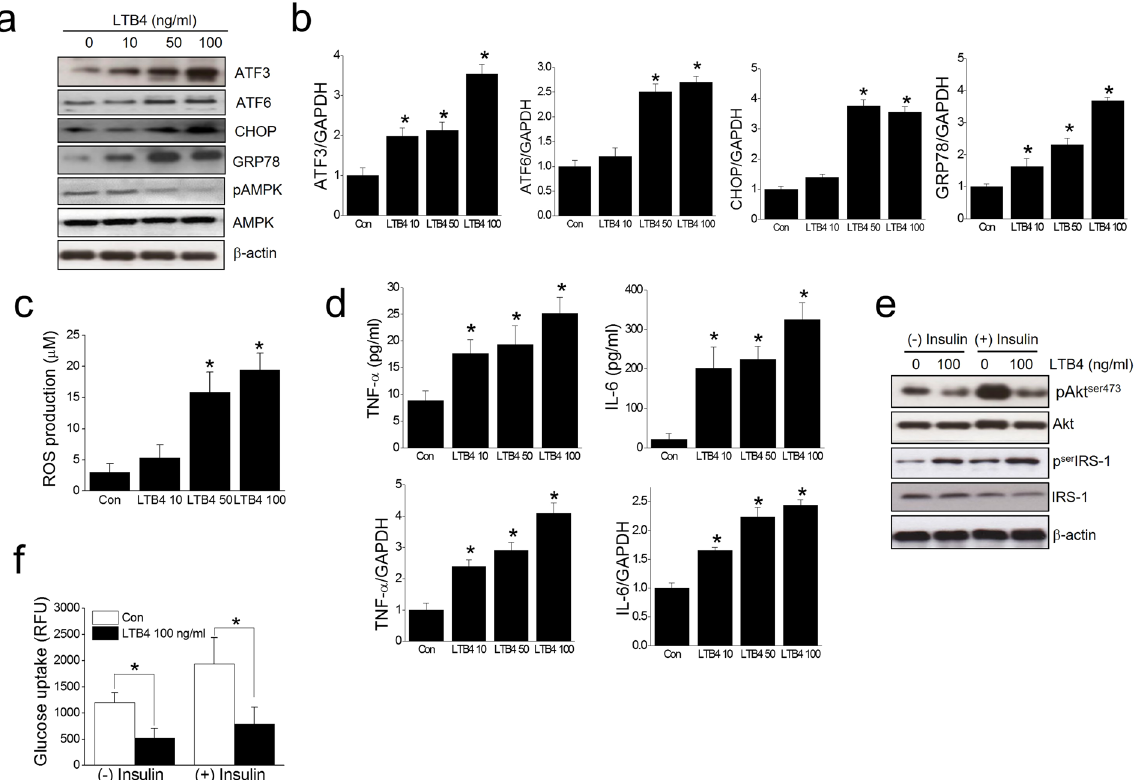
Figure 5. Effects of LTB4 on ER stress marker, oxidative stress, inflammation and insulin signaling. C2C12 myotubes were exposed to LTB4 (0–100 ng/ml) for 12 h (qPCR) or 24 h (western blot, ELISA, ROS, glucose uptake). The expression levels of ER stress markers were then determined by western blotting ( a ) and qPCR ( b ). ROS production was assessed using AmplexRed ( c ). Levels of pro-inflammatory cytokines were determined by ELISA and qPCR ( d ). Akt and serIRS-1 phosphorylation was assessed by western blotting ( e ), and glucose uptake was determined by 2-NBDG in the presence or absence of insulin (1 μ g/ml) for 30 min ( f ). The results